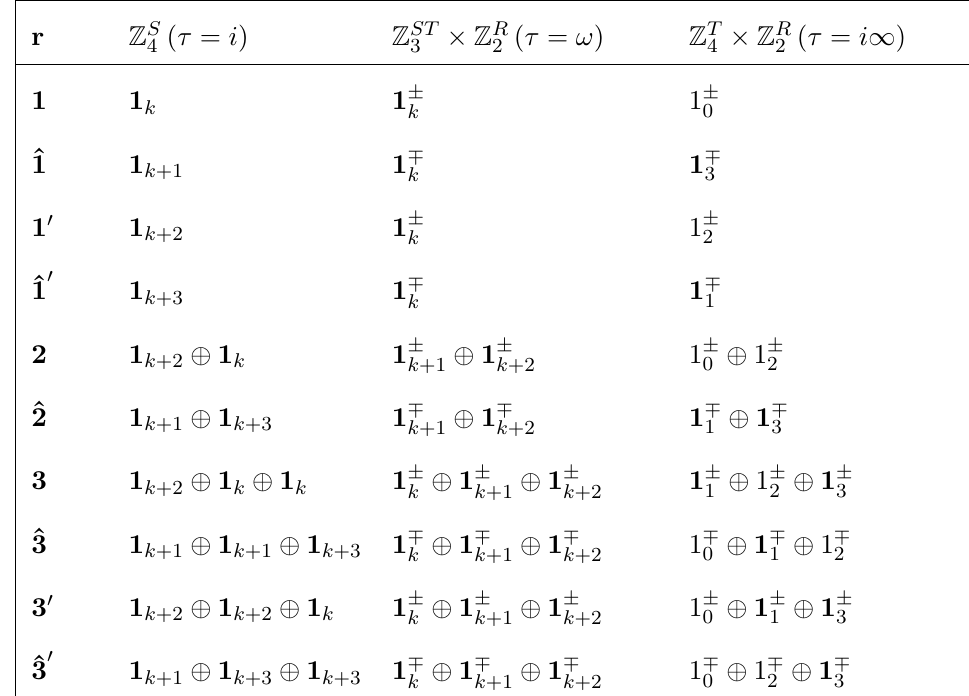
= SL(2 , Z ) under the residual ’ S 0 4 4 4